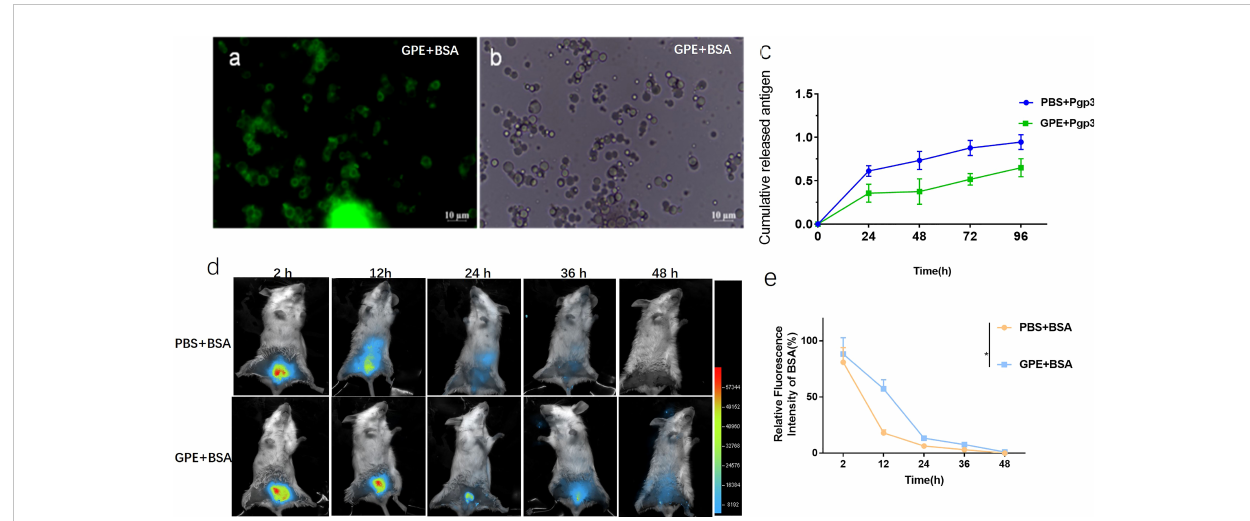
FIGURE 4 Optical micrograph of GPE after protein absorption. (A) GPE adsorbed FITC-BSA observed in bright fi eld; (B) GPE adsorbed FITC-BSA observed in dark fi eld; (C) antigen-controlled release of GPE + Pgp3; (D) fl uorescence intensity distribution at the injected site of representative mice; (E) fl uorescence intensity distribution at the injected site of representative mice, n = 3; all comparisons were done by two-way ANOVA here. FITC-BSA, fl uorescein labeled bovine serum albumin; GO, graphene oxide; GPE, GO-stabilized Pickering emulsion.